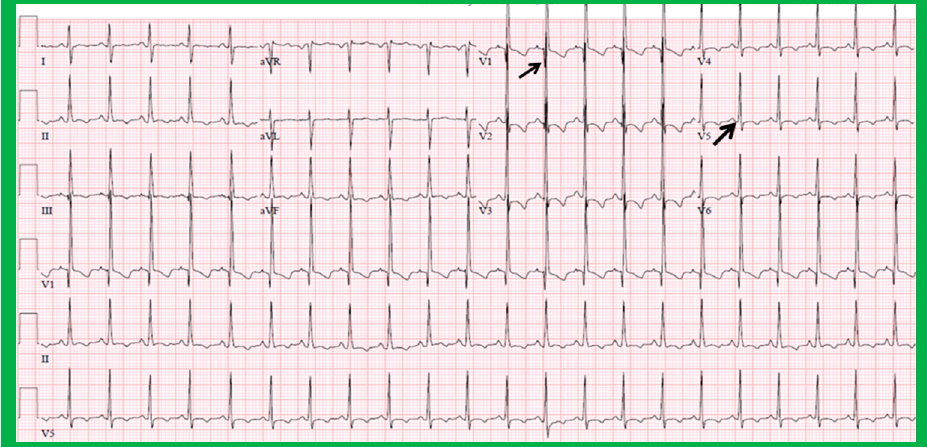
Figure 33. Electrocardiogram of a child illustrating q waves in lead V1 (top arrow) and no q waves in leads V5 and V6 (lower arrow). Such a pattern is indicative of inversion of the ventricles. However, such an abnormality has also been seen in subjects with severe right ventricular hypertrophy. A